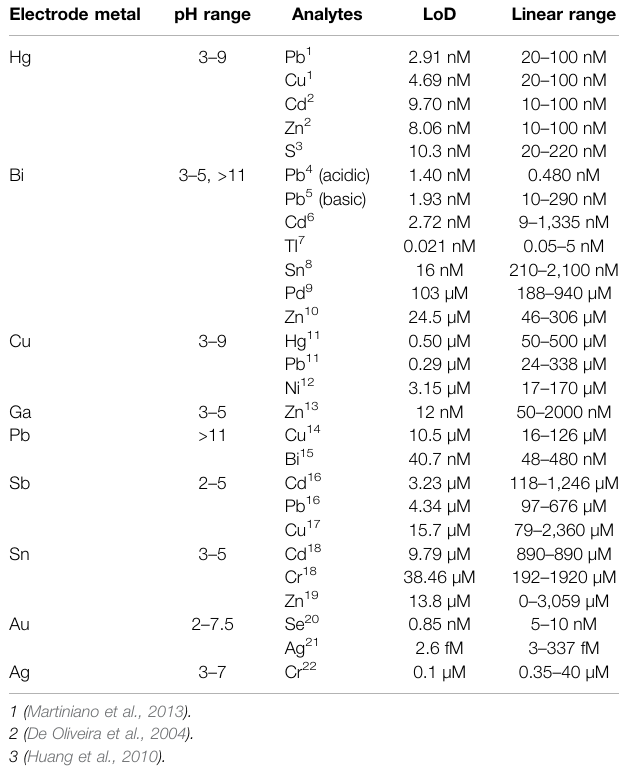
TABLE 1 | Overview of MTFEs metals, analytes, and sensitivities. Electrode